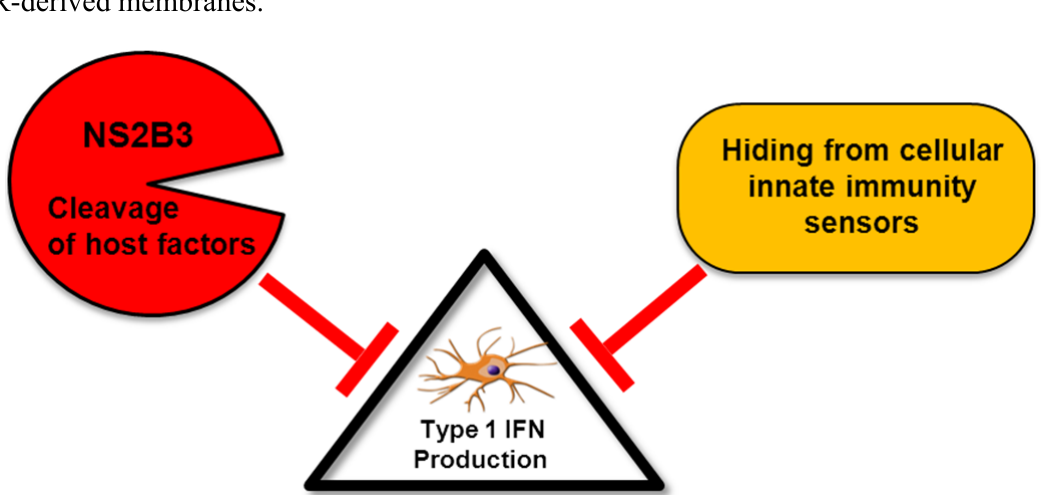
Figure 1. Model for inhibition of type I interferon (IFN) production by DENV: Dengue virus (DENV) can inhibit the induction of type I IFN using different strategies. The NS2B3 protease complex targets and cleaves still unidentified components of the type I IFN production pathway leading to the interruption of IRF3 phosphorylation. Furthermore, DENV can evade encounter with cellular sensors by hiding its replication products in ER-derived